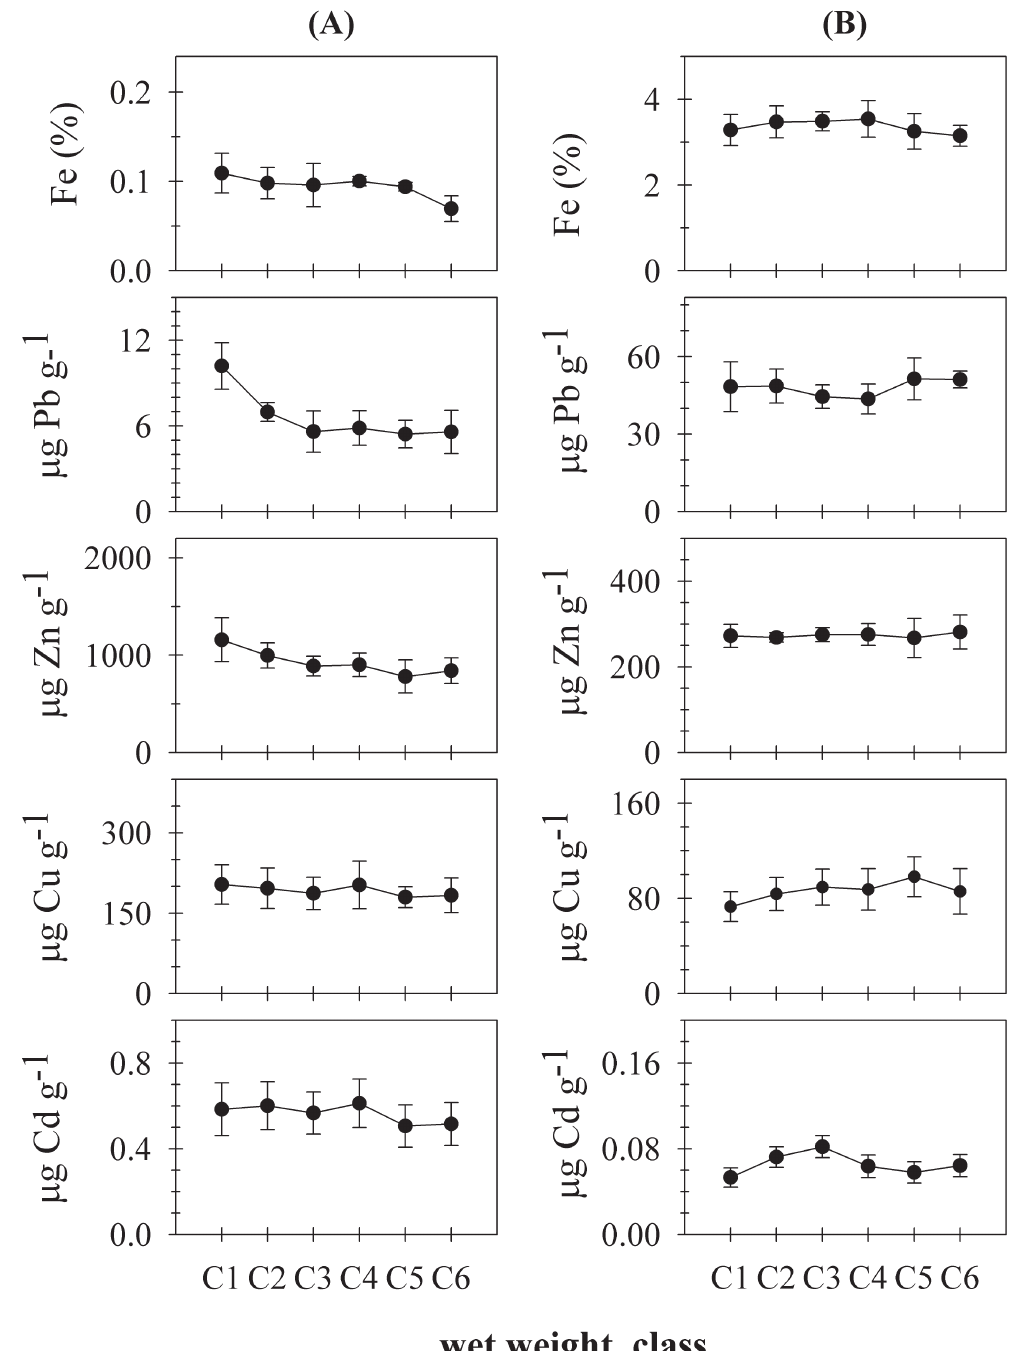
Fig . 5. – averaged metal concentrations (%±s.d. (Fe) and µg g -1 d.w.±s.d. (Pb, Zn, cu and cd) in each wet-weight class and in whole worm tissues (a) and faeces (B) along Águas de Moura channel. s.d. - standard deviation; c